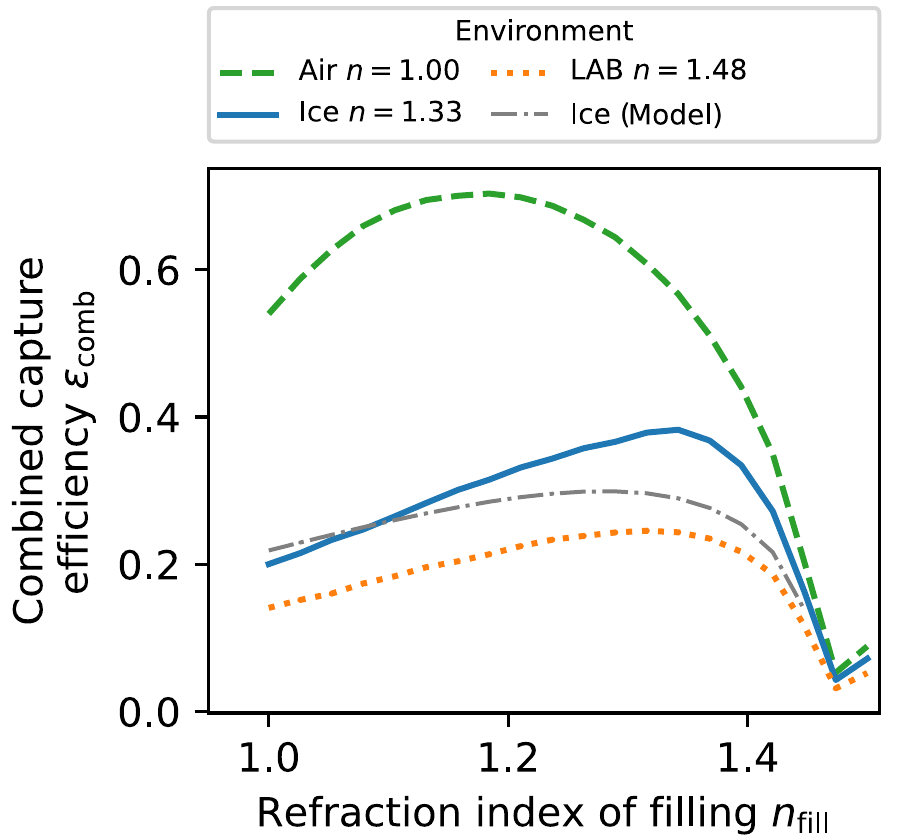
1 Figure 5. The combined efficiency for WOM operation in ice (or water), air, and LAB derived by simulating the propagation of 5 × 10 5 photons that are incident isotropically. The maximum achievable efficiency is 38.3% in ice at n ≈ 1.32, 70.3% in air at n ≈ 1.18, and 24.5% in LAB at n ≈ 1.32 (refractive index for LAB taken from Ref. [9]). For the geometry, the prototype design is used, as specified in Section